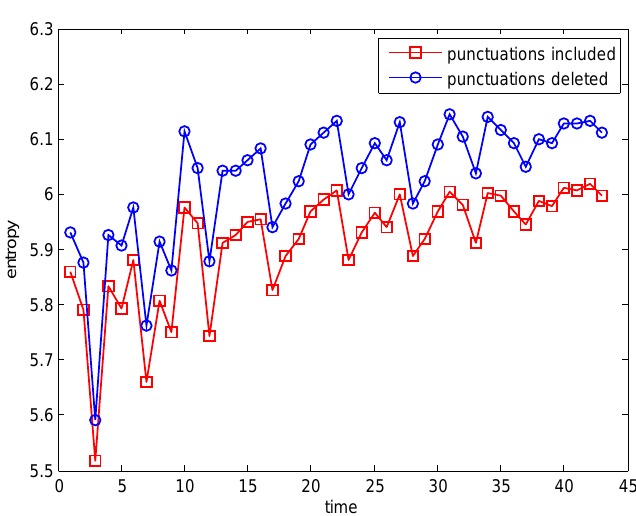
Figure 3: Scatterplot of the entropic